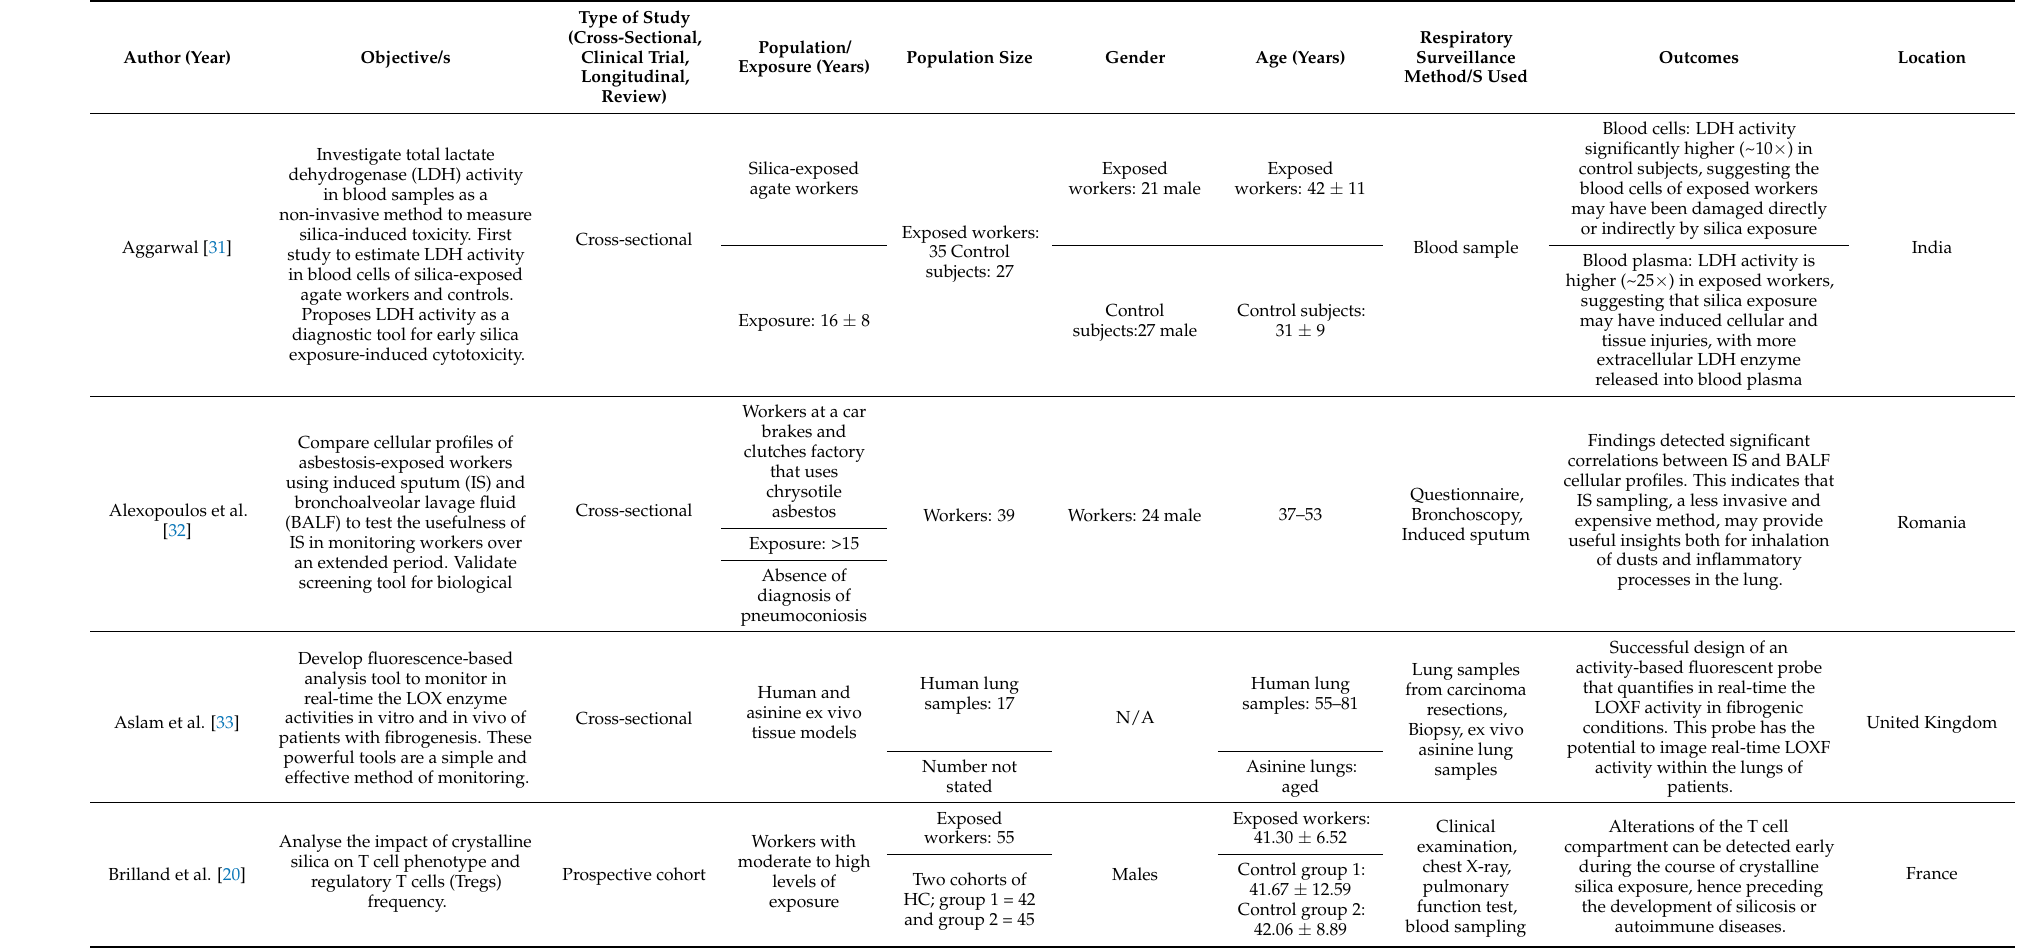
Table 2. Extraction table of the 52 articles included in the scoping